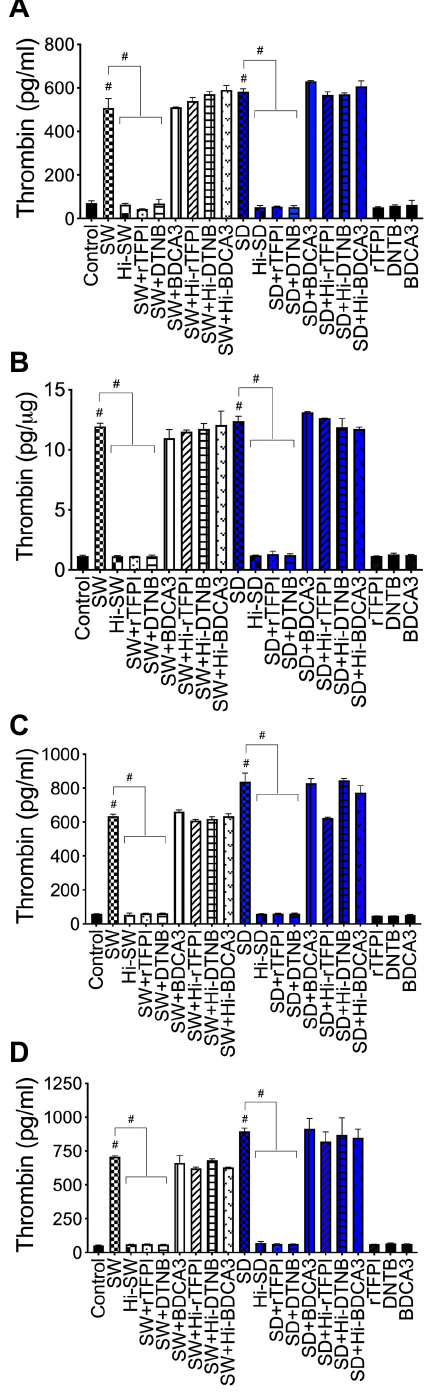
Figure 8. rTFPI and thiol blockers prevent S-proteins-induced thrombin expression and release in HLMEC, whereas TM had no effect: ( A , B ) HLMEC treated (24 h) with S-proteins (1 nM SW or SD), with or without rTFPI, DTNB, and BDCA3 (200 ng/mL); ( C ) HLMEC were treated 6 h with S-proteins, with or without rTFPI, DTNB, and BDCA3, washed, and co-cultured with neutrophils for 24 h; ( D ) human neutrophils were treated 6 h with S-proteins, with or without rTFPI, DTNB, and BDCA3, washed, and co-cultured with HLMEC for 24 h. Following treatments, thrombin levels in culture supernatants ( A , C , D ) and endothelial cells lysates ( B ) were quantified by ELISA. Data presented as mean ± standard deviation. Control: untreated cells; Hi: heat-inactivated (SW, SD, rTFPI, DTNB, BDCA3). # p <